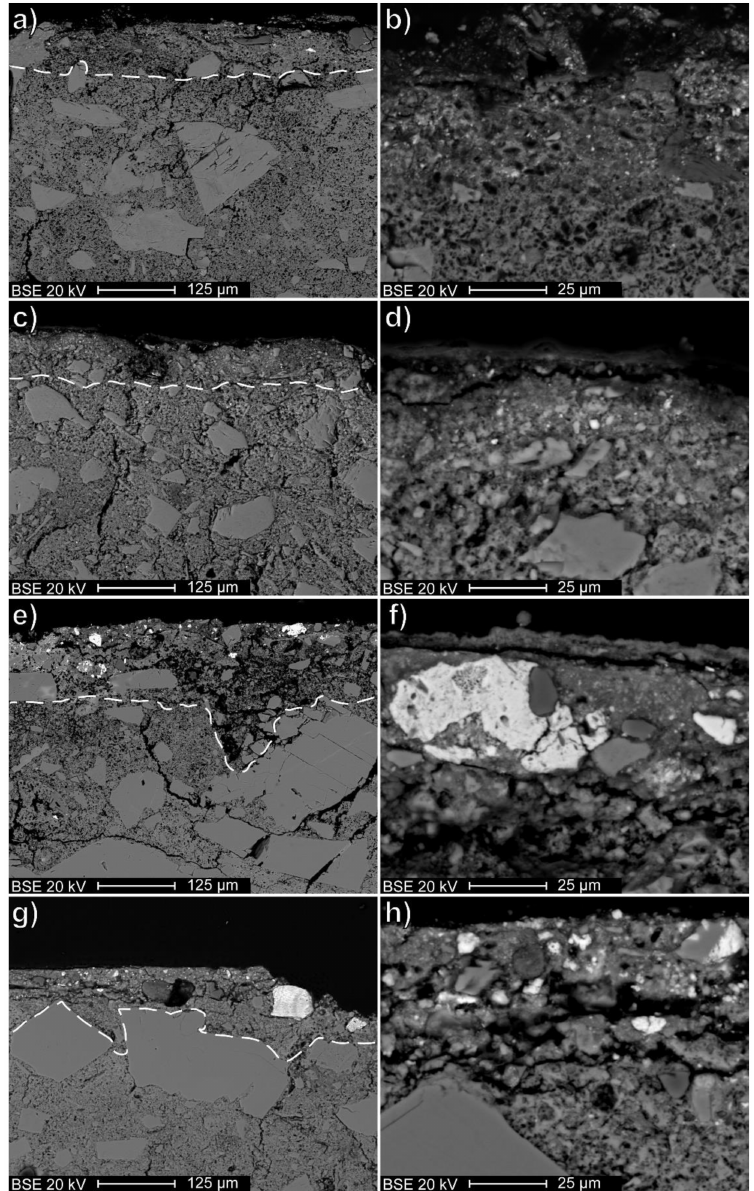
Figure 8. Representative backscattered electron (BSE) images of the Herculaneum samples (inter- faces between plasters and paint layers are indicated by dashed lines): ( a ) BCN_28, upper portion; ( b ) BCN_28, detail of the paint layer; ( c ) BCN_W1_03, upper portion; ( d ) BCN_W1_03, detail of the paint layer; ( e ) BCN_31, upper portion; ( f ) BCN_51, detail of the paint layer; ( g ) BCN_67, upper portion; ( h ) BCN_67, detail of the paint